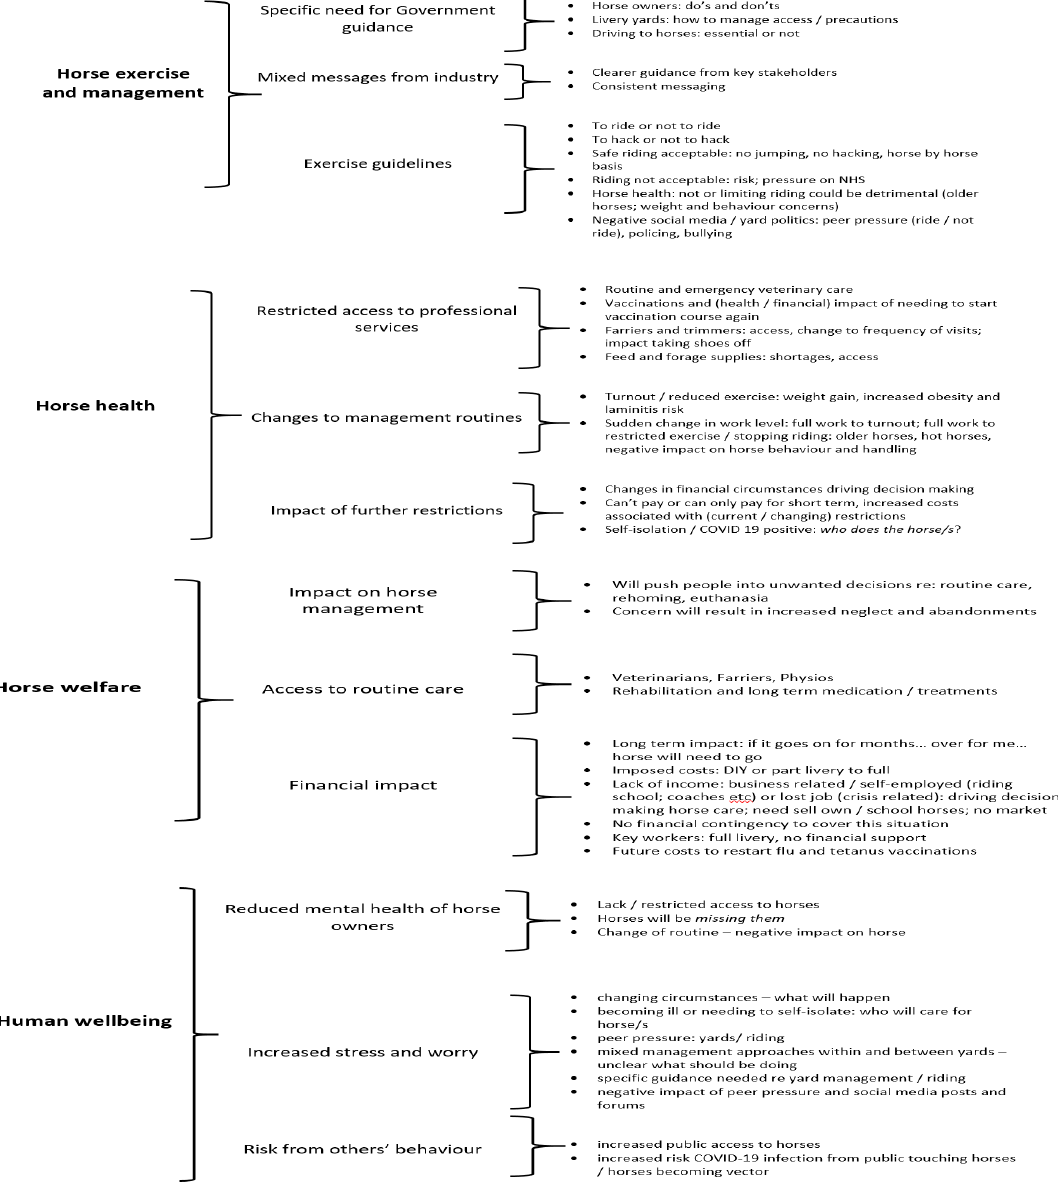
Figure 8. Thematic analysis of the horse owners’ perceptions of the current impact of the